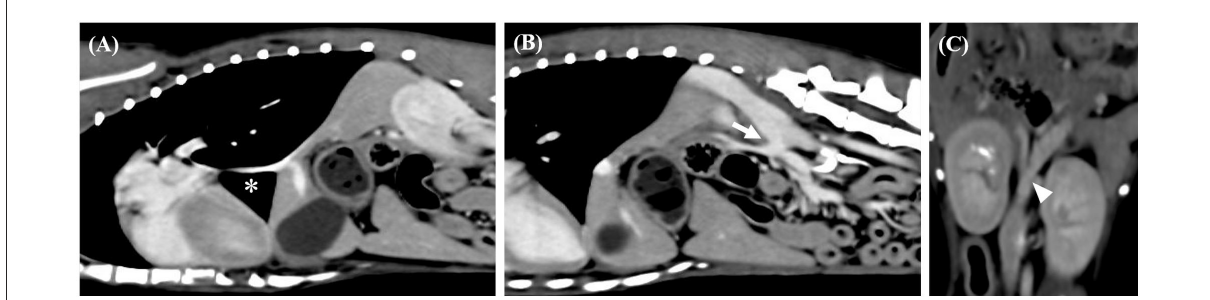
FIGURE5 Sagittal computed tomography images from the late post-contrast series of cases 2. (A,B) Segmental caudal vena cava aplasia (asterisk) and portosystemic shunt (arrow) were observed. Dorsal computed tomography images from the late post-contrast series of cases 2. (C) The white arrow head indicates caudal portion of the shunt.